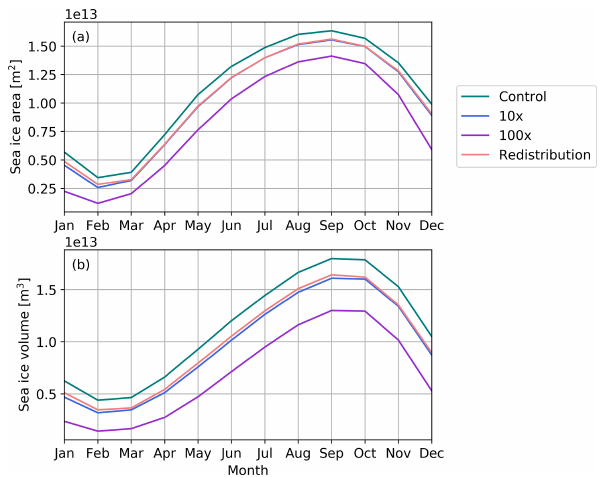
Figure 8. Seasonal cycle of Southern Hemisphere (a) sea ice area (m 2 ) and (b) sea ice volume (m 3 ) for all sensitivity runs with prein- dustrial forcing – control run (teal), 10 × lateral melt run (blue), 100 × lateral melt run (purple), and redistributed lateral melt (light red). Results shown are averages over the last 5 run years for the redistributed lateral melt run and the last 25 years for all